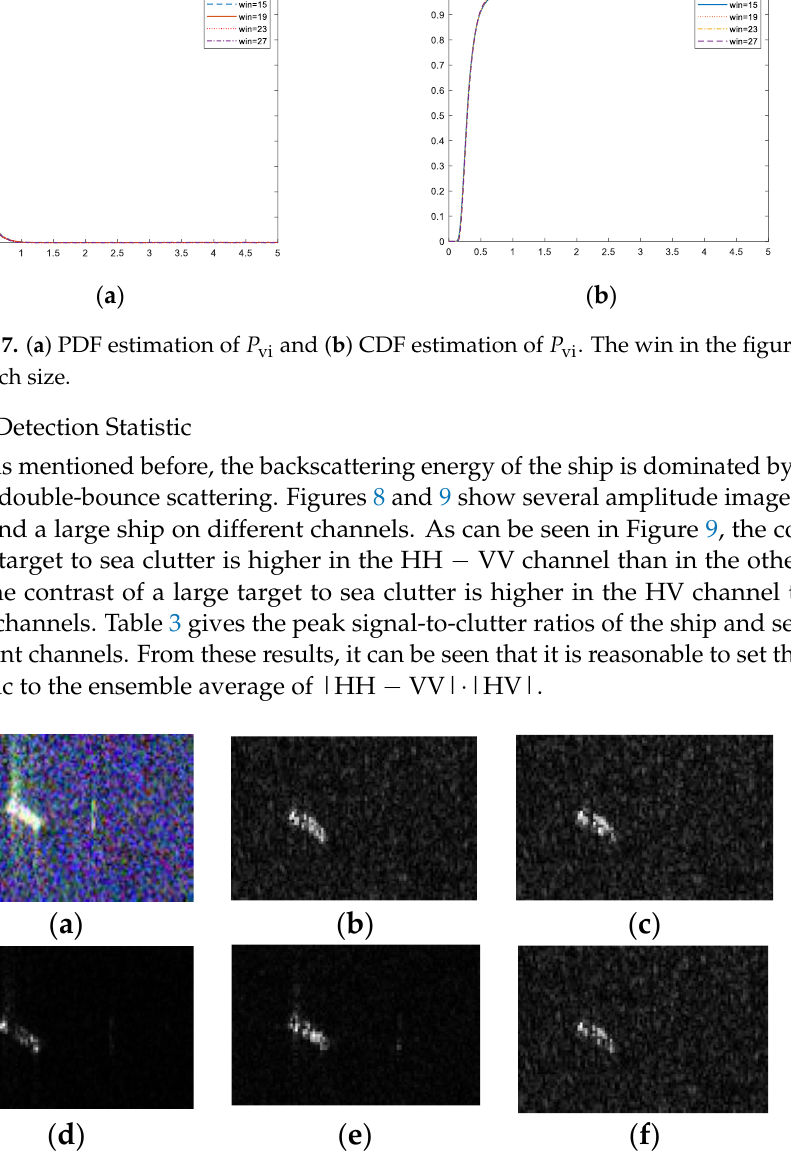
Figure 6. Histogram of 𝑃 vi under different patch sizes: ( a – d ) patch size = 15, 19, 23, 27.